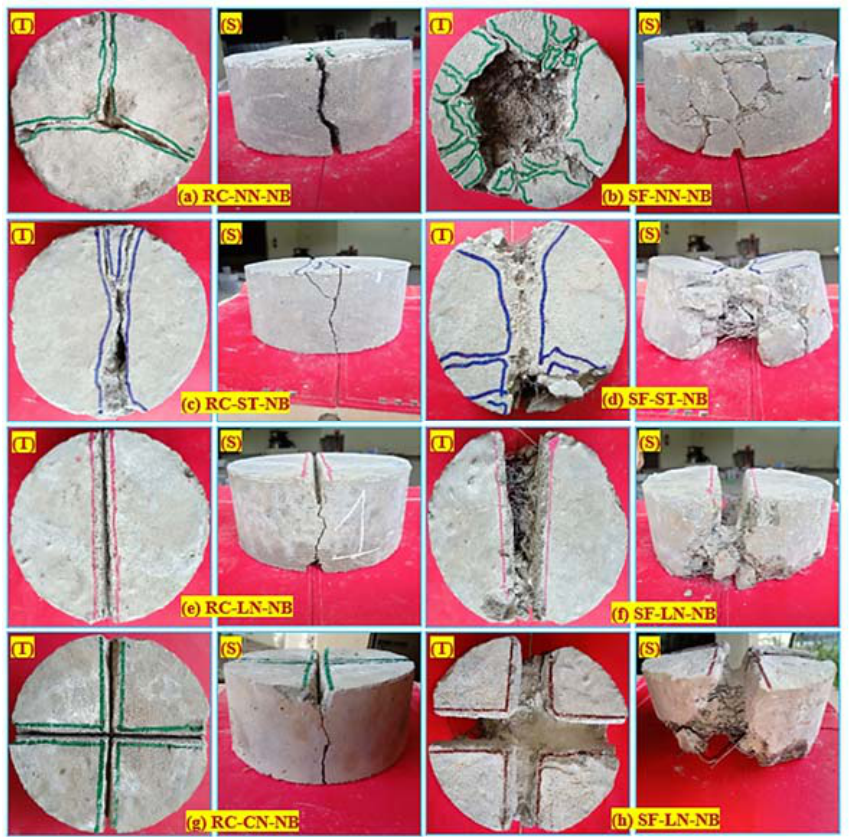
Figure 22. Failure pattern. ( a ) RC ‐ NN ‐ NB (b ) SF ‐ NN ‐ NB ( c ) RC ‐ ST ‐ NB ( d ) SF ‐ ST ‐ NB ( e ) RC ‐ LN ‐ NB ( f ) SF ‐ LN ‐ NB ( g ) RC ‐ CN ‐ NB and ( h ) SF ‐ LN ‐ NB; where T ─ top and S ─ Side.